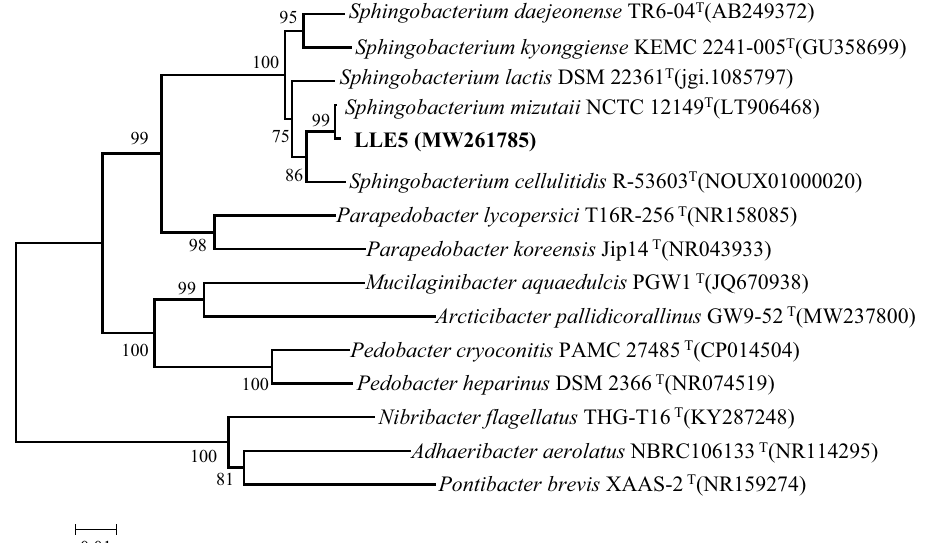
Figure 2. Neighbour-joining phylogenetic tree based on a comparison of the 16S rRNA gene sequences of S. mizutaii LLE5 and its closest relatives and several out-group strains. The numbers at the nodes indicate the percentages of bootstrap sampling derived from 1000 replications. GenBank accession numbers are given in parentheses. Bar, 0.01 nucleotide substitution per nucleotide